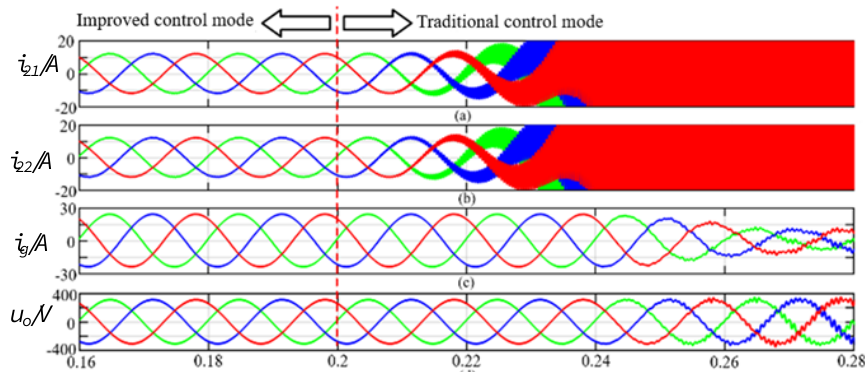
Figure 11. Simulation results of parallel inverters with the same capacity switching from improved control mode to traditional control mode: ( a ) current waveform of inverter 1; ( b ) current waveform of inverter 2; ( c ) total current waveform; and ( d ) voltage waveform of the point of common coupling (PCC).